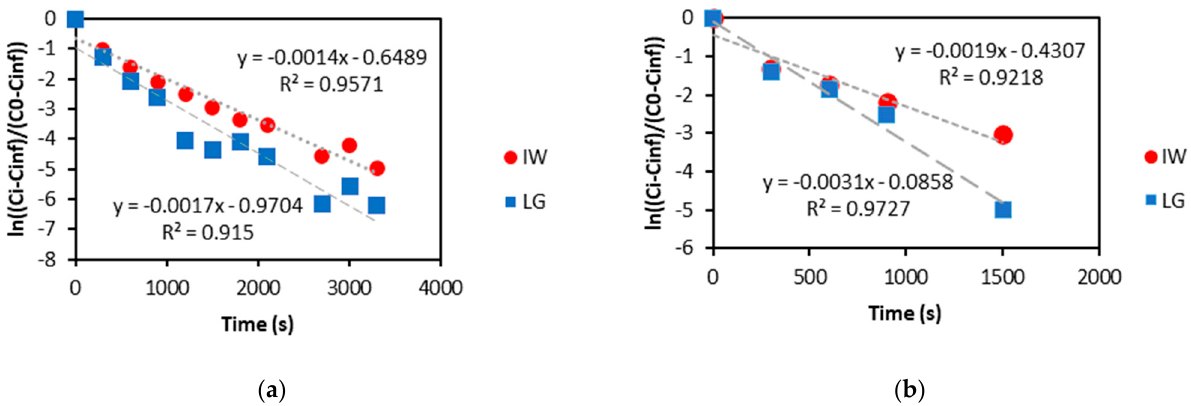
Figure 4. Plot of ln (C i − C inf )/(C 0 − C inf ) versus time (s) for ( a ) K + and ( b ) NO 3 − nutrient release results for IW and LG slow-release fertilisers to determine the diffusion coefficients using Equation (3).